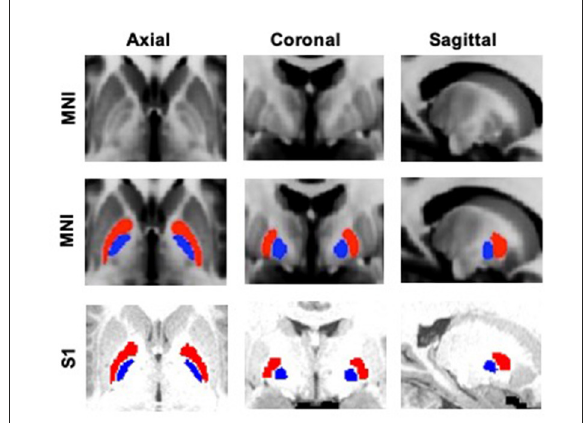
FIGURE1 GPe (red) and GPi (blue) ROIs overlaid on standard MNI (Montreal Neurological Institute) 1mm template and a sample subject’s (S1) T1